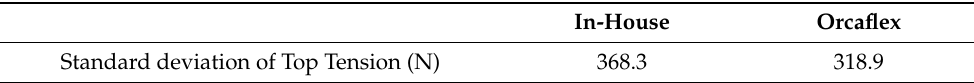
Table 2. The standard deviation of top tension for single-component case.